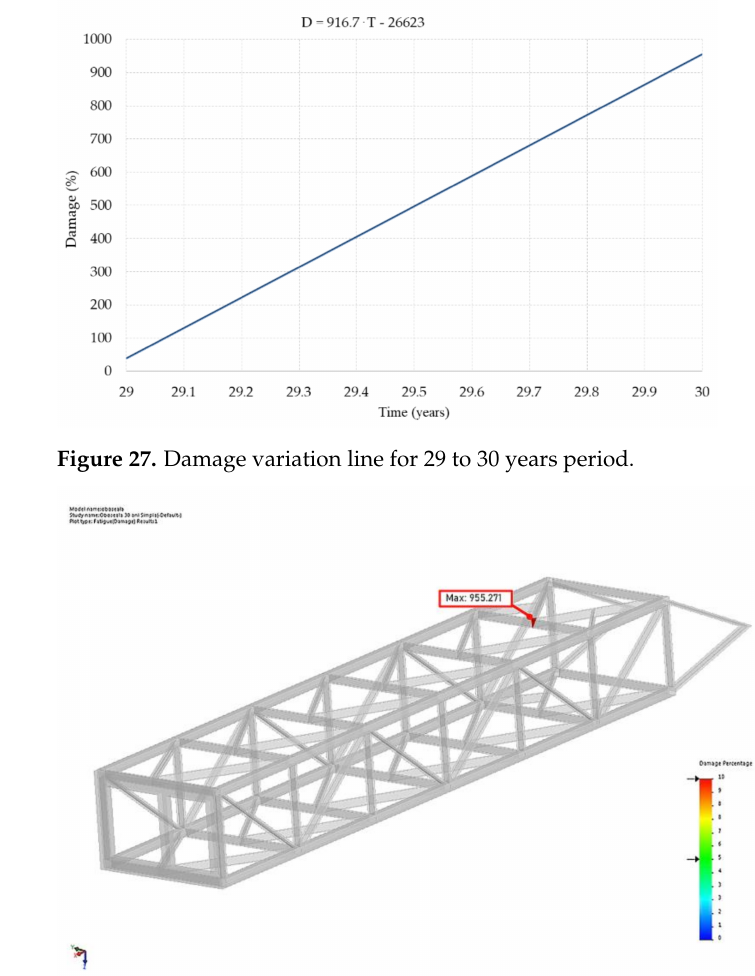
Figure 28. Damage min/max location for T = 30